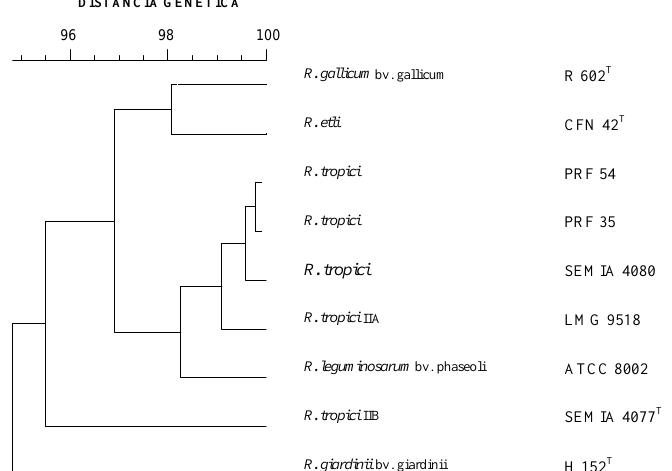
Figura 2. Dendrograma (UPGMA) mostrando as relações genéticas entre os genes 16S rRNA das estirpes SEMIA recomendadas para a cultura do feijoeiro e das estirpes representativas das espécies de Rhizobium capazes de nodular essa leguminosa.